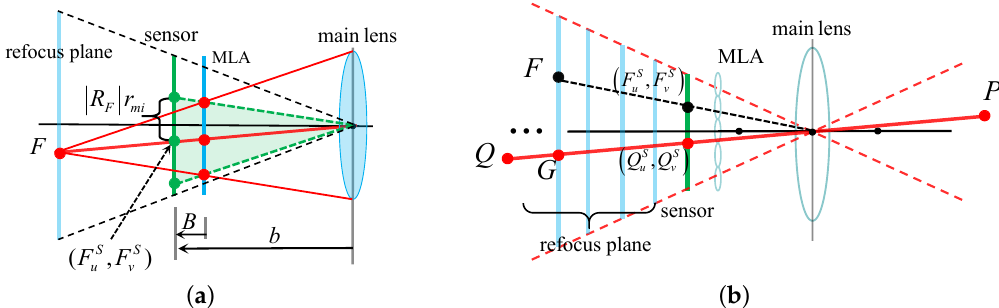
Figure 3. Illustration of proposed refocusing algorithm. ( a ) Illustration of plenoptic disc data. ( b ) Illustration of central projection refocusing